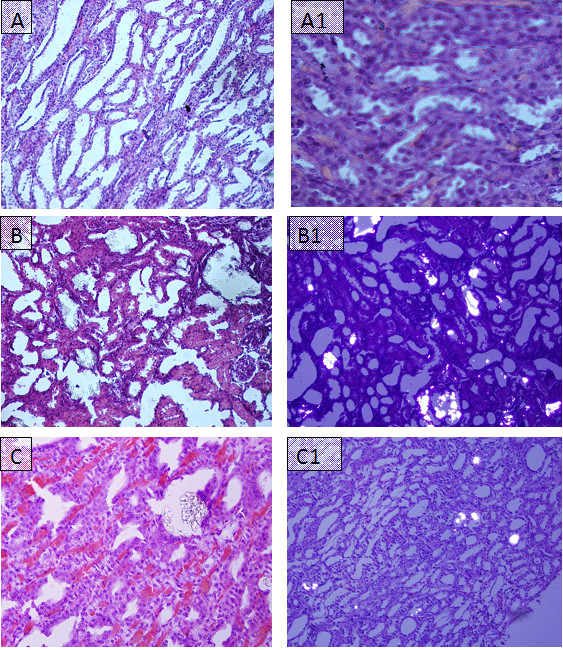
Microscopic images of Kidney sections in curative study. Representative microscopic images of the H and E of the kidney sections from normal (A), Lithogenic group (B) and Treated (C) with Ov.Cr. A1, B1 and C1 show the polarized images of the sections.